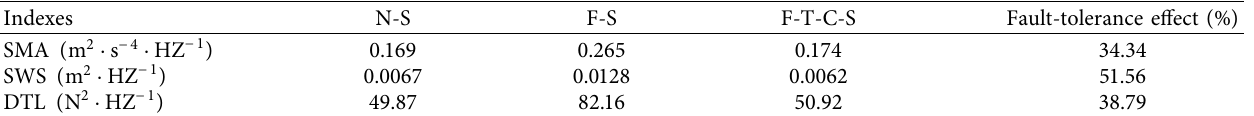
Table 6: The highest peak values in frequency domain under random